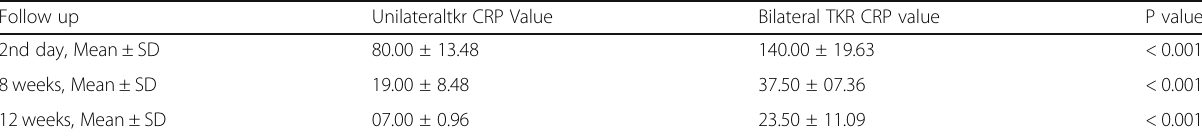
Table 5 Two sample t test, p value calculation between unilateral and bilateral TKR Follow